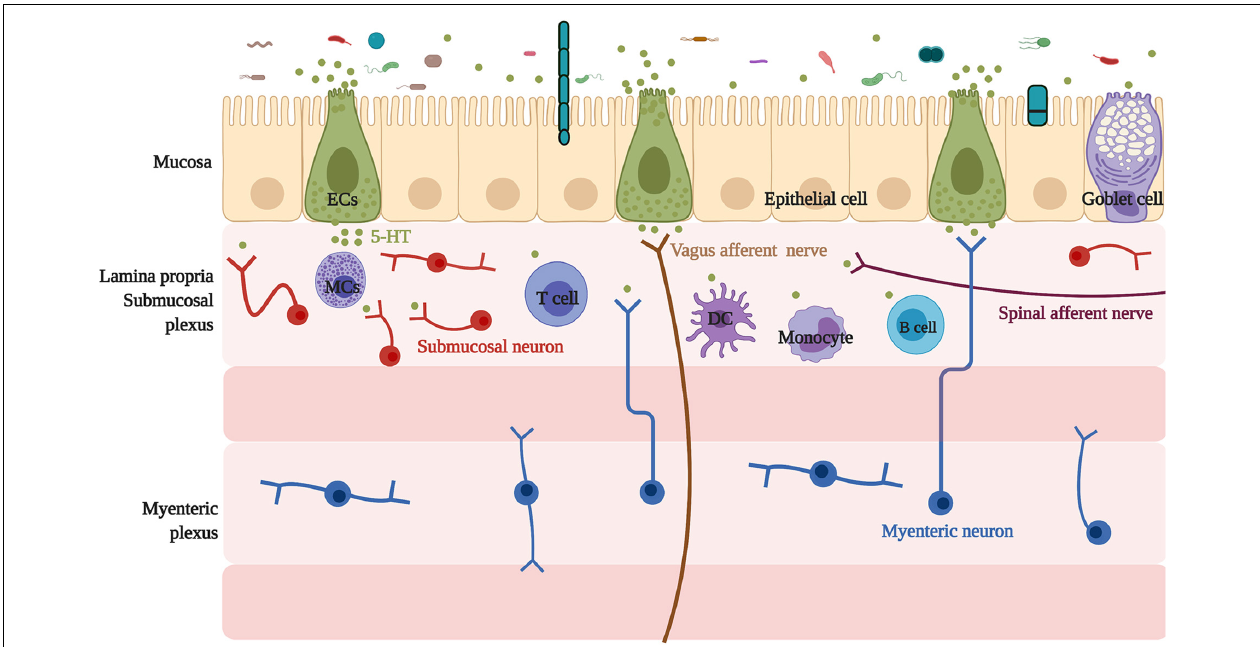
FIGURE 1 | Location of enterochromaffin cells and their association with neighbor cells and neurons. Located on the intestinal mucosal surface, the epithelial layer, ECs have a relationship with neighboring cells, including epithelial and goblet cells, and connect with the submucosal neuron, the myenteric neuron projecting into the submucosal, and nerve endings of the vagal and spinal afferents. In addition, ECs are linked with various immune cells, such as mast cells, monocytes, dendritic cells, T cells, and B cells. ECs, enterochromaffin cells; 5-HT, 5-hydroxytryptophan/serotonin; MCs, mast cells; DC, dendritic